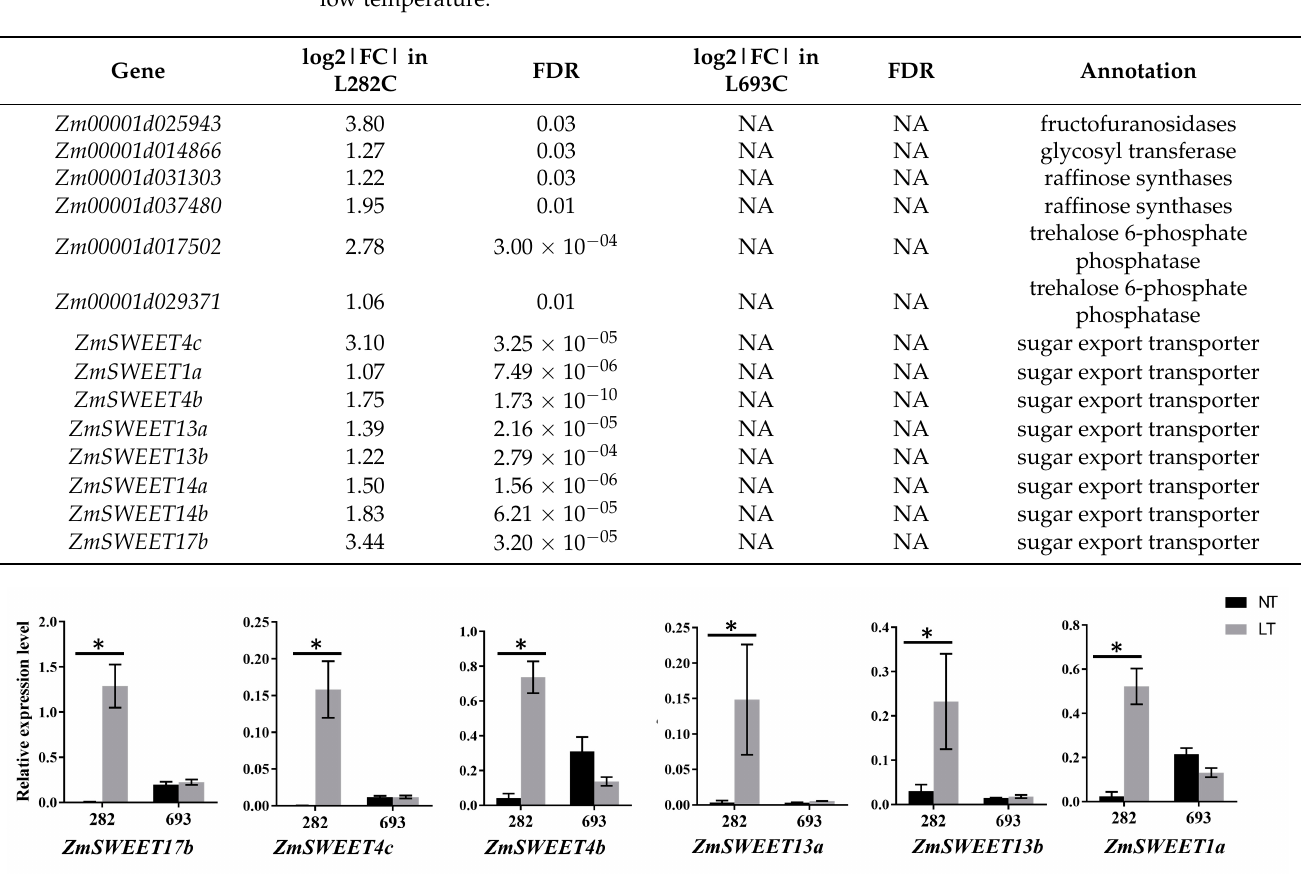
Figure 6. qRT-PCR analysis of six ZmSWEET genes expressed in L282 and L693 at normal temperature (NT) and low temperature (LT). The asterisks indicate significant difference at p < 0.05 (n = 3). A GO analysis was performed to detect the functional pathways of the sDEGs (Table 3).